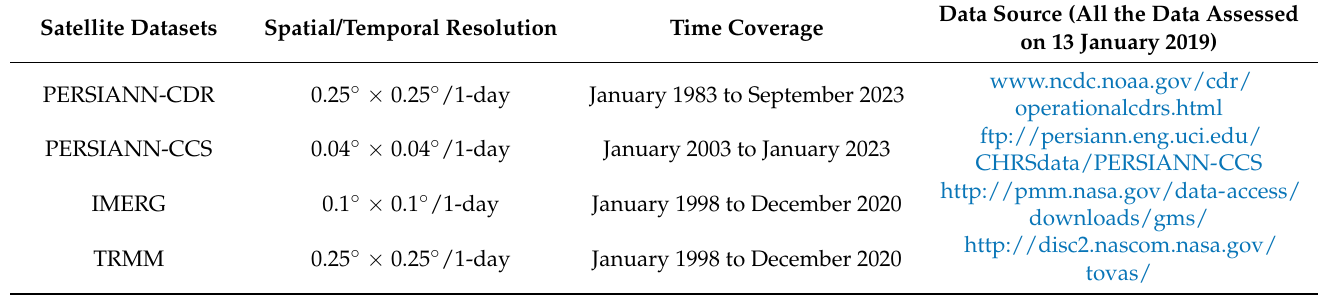
Table 2. Salient features of SBPD.